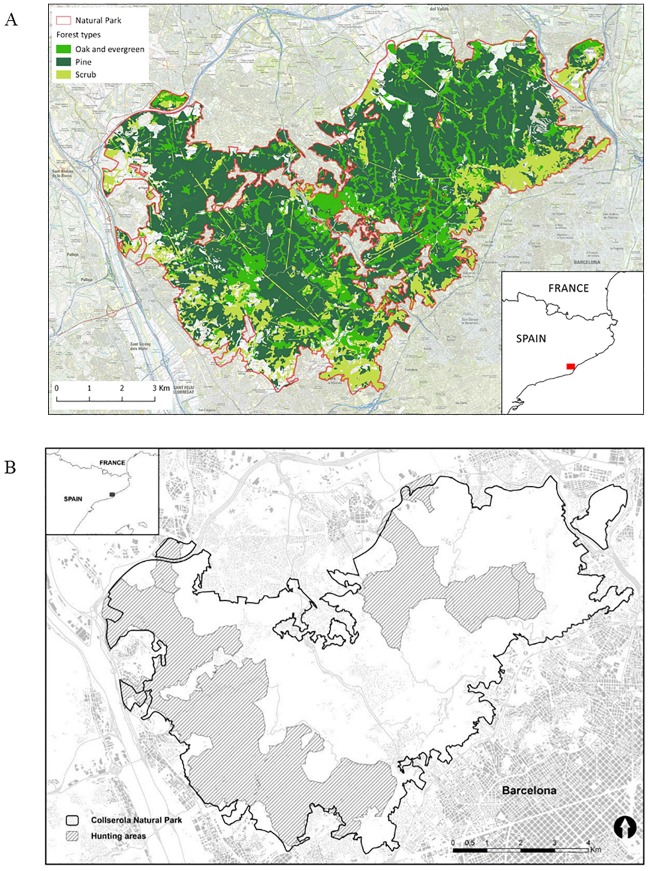
Study area.Maps of Collserola Natural Park, Barcelona, NE Spain, showing a) the different habitats and b) Controlled Game Area, currently the only hunting areas in the whole massif.